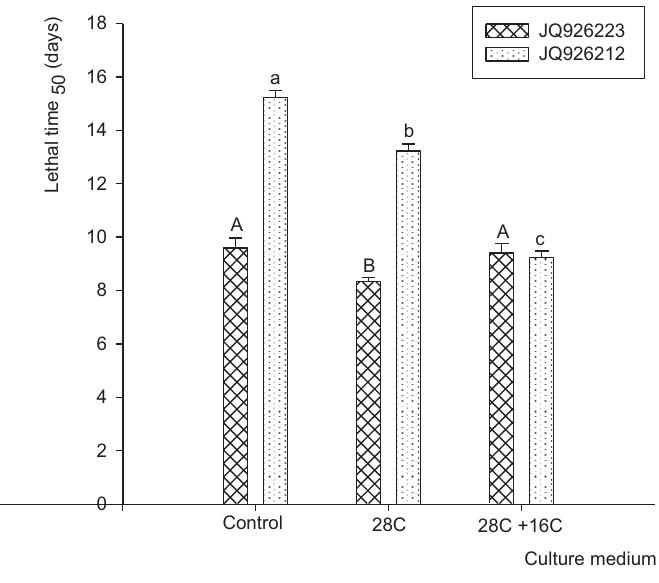
Figure 4. LT 50 for T. confusum adults exposed during 15 days to two strains of P. lilacinum JQ926212 and JQ926223 grown in control medium and amended medium with 28C and 28C + 16C mixture. Data with different letters for each strain (JQ926223: capital letters, JQ926212: small letters) at different treatments are significantly different based on the Tukey test ( P <